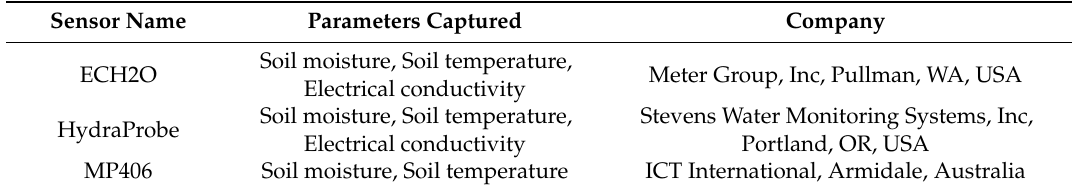
Table 2. Popular wireless nodes used in the agriculture